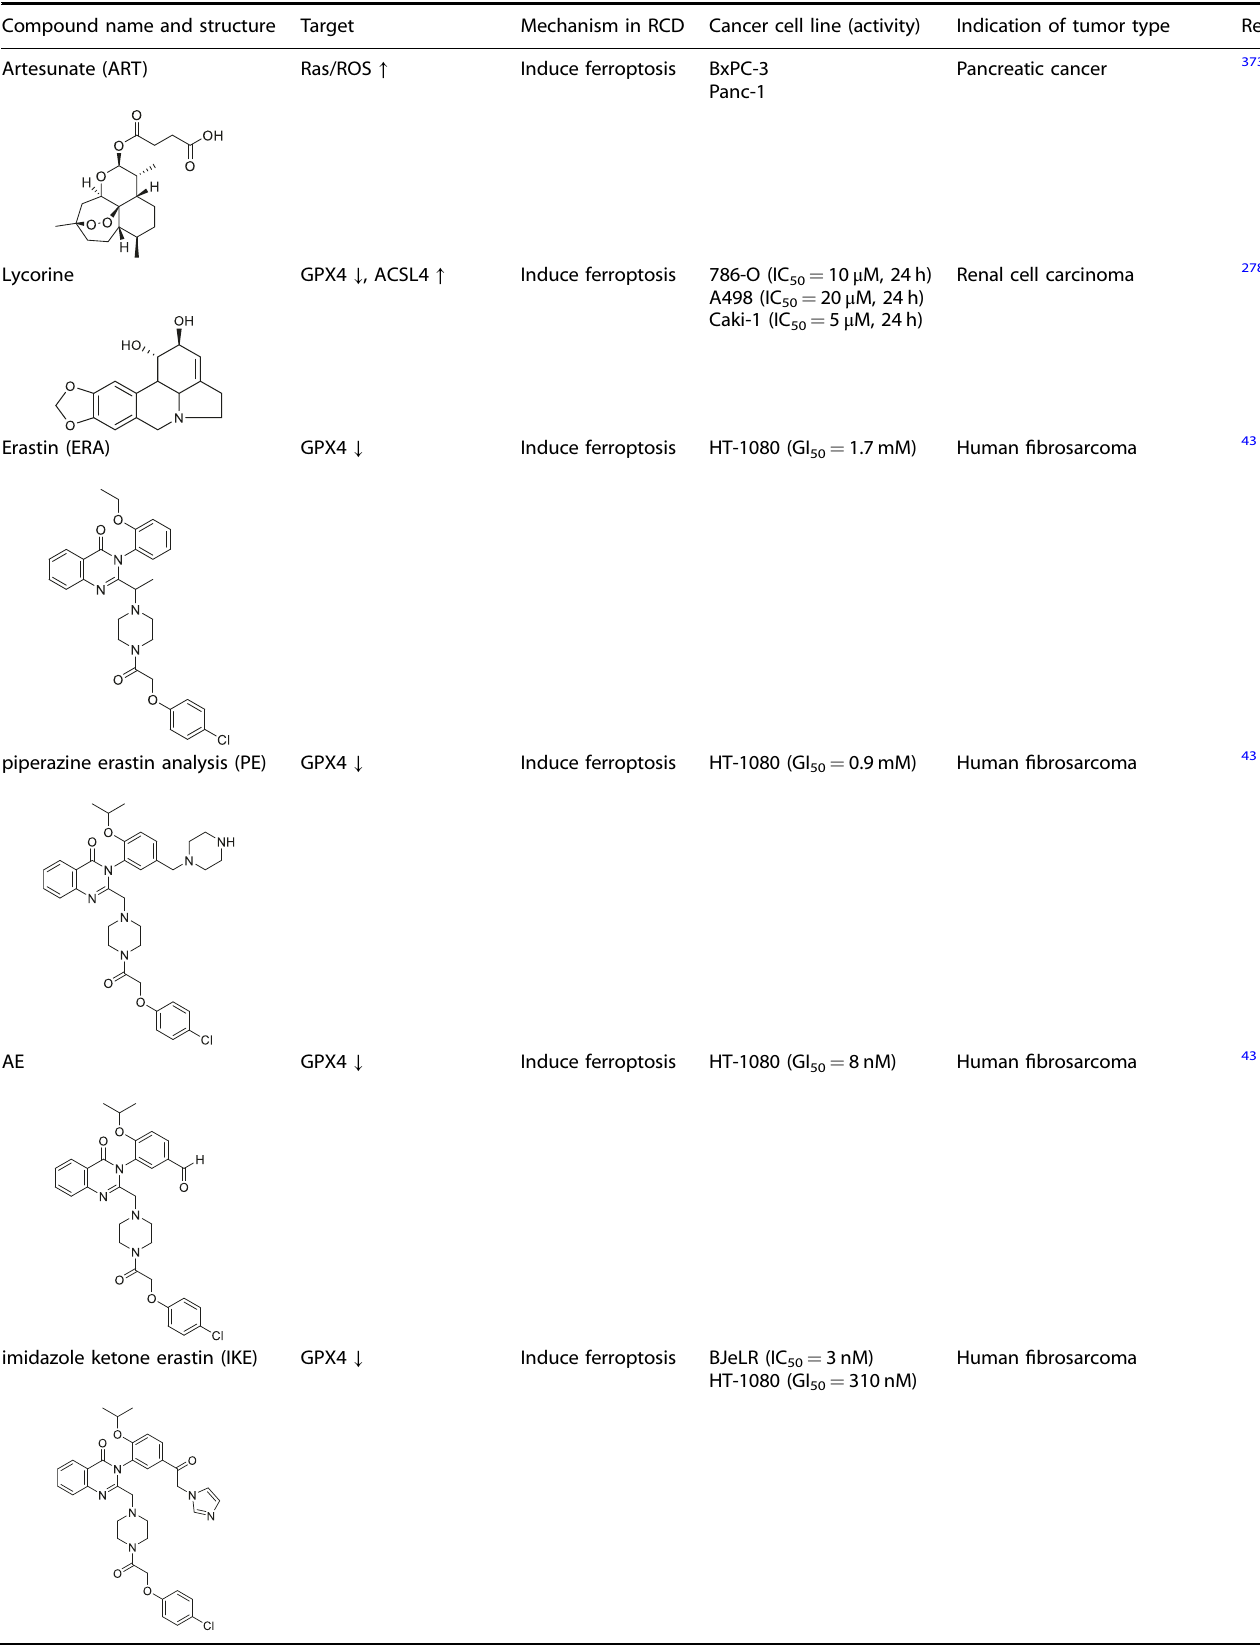
Table 12. Compounds targeting ACSL4/LPCAT3/ALOX15, SLC7A11/GPX4/NFE2L2 and other targets of ferroptosis in